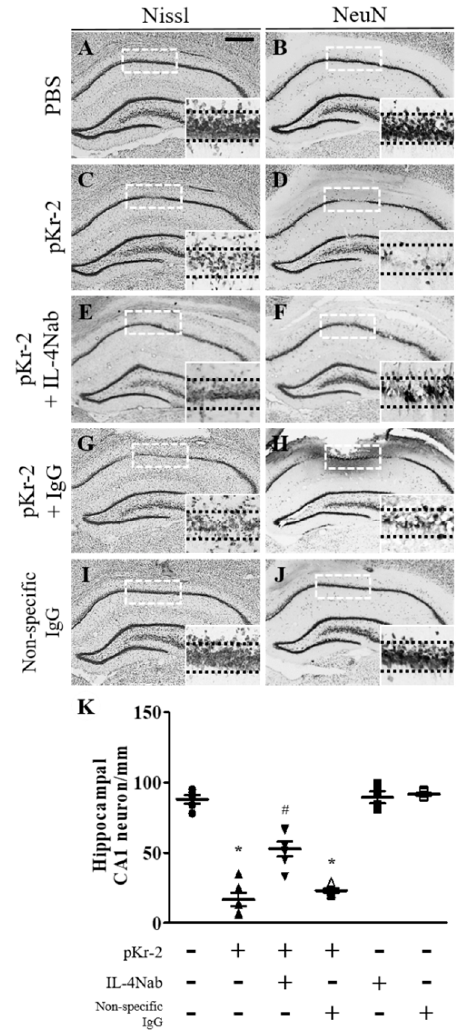
Figure 4. IL-4-mediated neurotoxicity in the CA1 layer of pKr-2-injected hippocampus in vivo. Animals unilaterally received intrahippocampal injection of PBS ( A , B ) as a control, pKr-2 ( C , D ), pKr-2 + IL-4Nab (1 µ g; E , F ), pKr-2 + non-specific IgG (1 µ g; G , H ), and non-specific IgG only (1 µ g; I , J ). At 3 days after injection, animals were transcardially perfused and brain tissues were processed for Nissl staining or neuronal nuclei (NeuN) immunostaining at 3 days after pKr-2 injection. ( A , C , E , G , I ) CA1 layer of the hippocampus stained for Nissl substance. ( B , D , F , H , J ) NeuN immunostaining in the CA1 layer of hippocampus. Insets show magnified photomicrographs in the CA1 layer marked by dotted rectangles, respectively. Scale bar, 500 µ m. ( K ) Number of NeuN + cells in the CA1 layer of pKr-2-injected hippocampus in the absence or presence of IL-4Nab. * p < 0.001, significantly di ff erent from PBS. # p < 0.001, significantly di ff erent from pKr-2. mean ± SEM; n = 4 to 6 in each group, ANOVA and Newman–Keuls analysis.